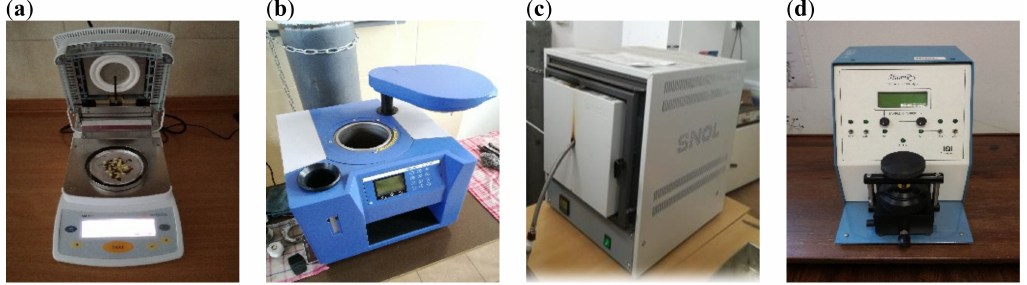
Figure 2. Devices in the technical analysis stand test: ( a ) moisture analyzer SARTORIUS MA150, ( b ) calorimetric bomb IKA C200, ( c ) mu ffl e furnace SNOL 8,2 / 1100, ( d ) gas pycnometer